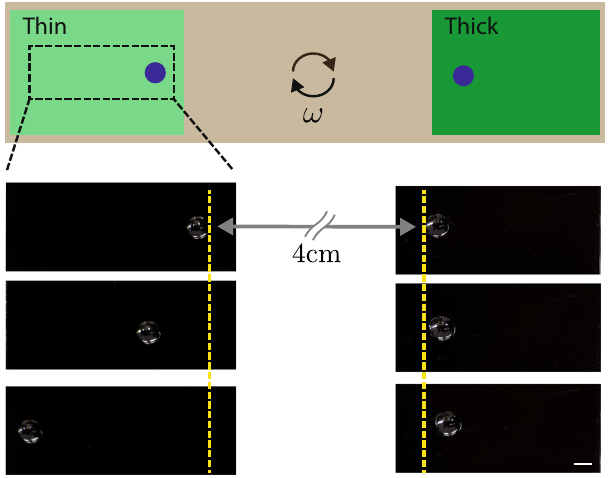
Fig. 5 | Centripetal forcing of droplets. Schematic and image sequence of cen- tripetal forcing experiment of glycerol droplets on opposed thick ( h >1000 nm) and thin ( h <100 nm) PDMS fi lms. The top image represents initial position of the droplets.Subsequentframesareseparatedby30srotationsonaspincoaterat200 rpm. The scale bar is 2